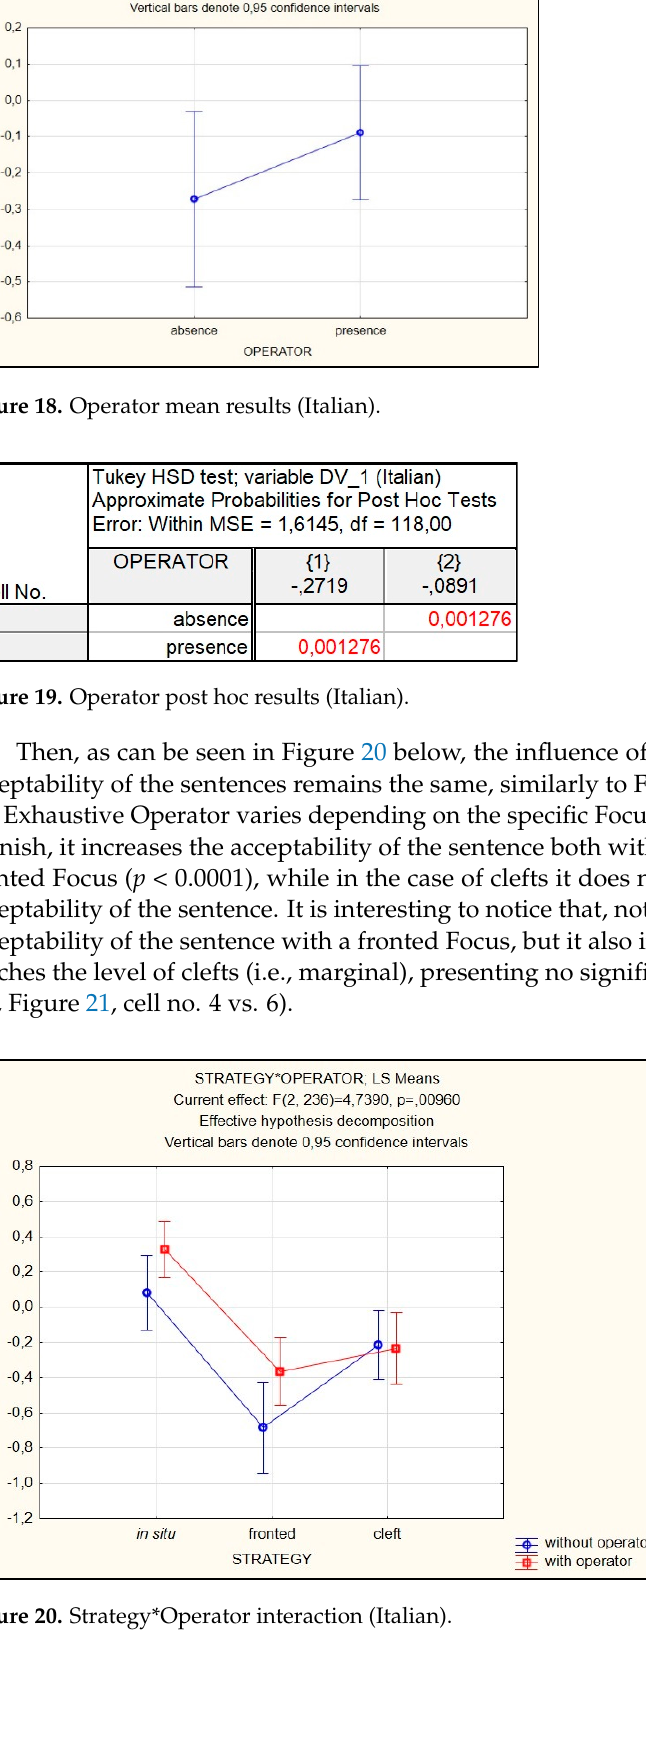
Figure 21. Strategy*Operator post hoc results (Italian) . These results seem to confirm a negative answer to our first research question, since the combination of exhaustive and corrective features does not seem to favor FF in Italian (just like in Finnish). Indeed, Italian native speakers, similar to their Finnish counterparts, always prefer an in situ realization of the focused constituent in this context, while considering fronting unacceptable. Finally, the fact that the acceptability of FF is also